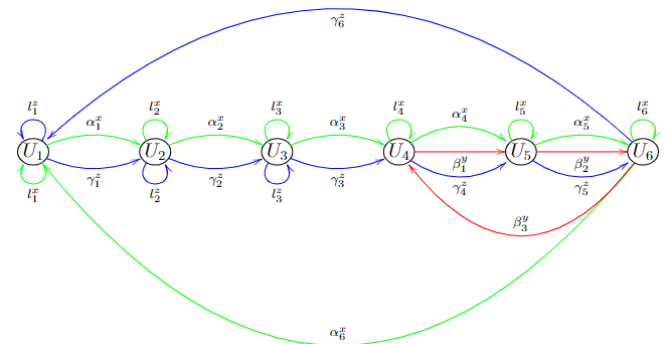
induced by the Brauer configuration B (( √ 3, √ 3 ) , f 1 , f 2 ) Figure 7. Brauer quiver Q B (( √ 3, √ 3 ) , f 1 , f 2 )